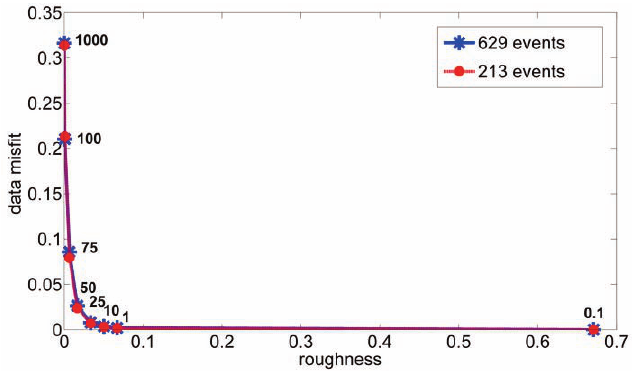
Figure 7. Trade-off curve for the selection of the damping parameter k, obtained for the two different datasets of events. Each point or star on the curve represents one inversion carried out with the indicated value of